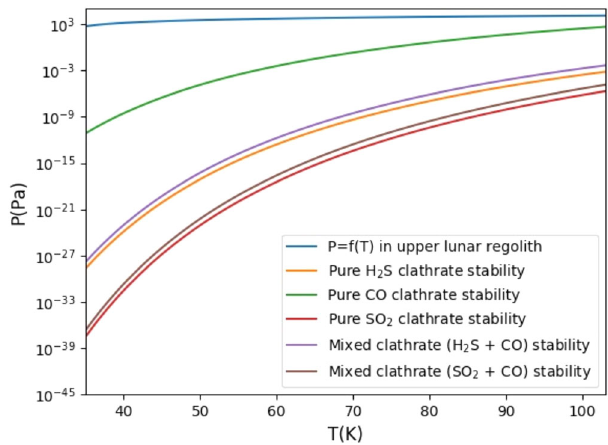
Fig. 2 Stability curves for clathrates stored in the permanently shaded regions. Clathrates are stable above and to the left of the curve. Comparison of (top blue line) the pressure-temperature pro fi le, or P = f ( T ), in the upper lunar regolith (0.2 – 5 m) to stability curves for clathrates with SO 2 , H 2 S, CO, and mixtures of these species as noted in the legend 31,34,35 . The P = f ( T ) pro fi le is calculated based on a temperature pro fi le extrapolated from ref. 12 and pressure based on a 1.66 g/cm 3 lunar regolith 36 . Mixed clathrate stability curves are based on clathrates formed from gas mixture of CO + SO 2 or H 2 S (with a cometary C/S from ref. 21 ); such clathrate is dominated by SO 2 or H 2 S. Because the P = f ( T ) for the lunar regolith falls in the area above and to the left of all stability curves, the regolith is within the clathrate stability